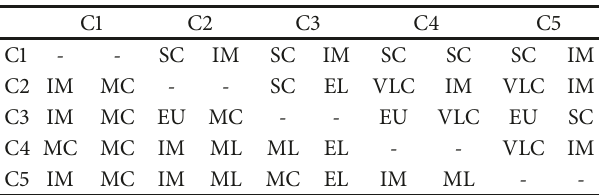
Table 5: Criteria of evaluation using fuzzy AHP and fuzzy DEMA-